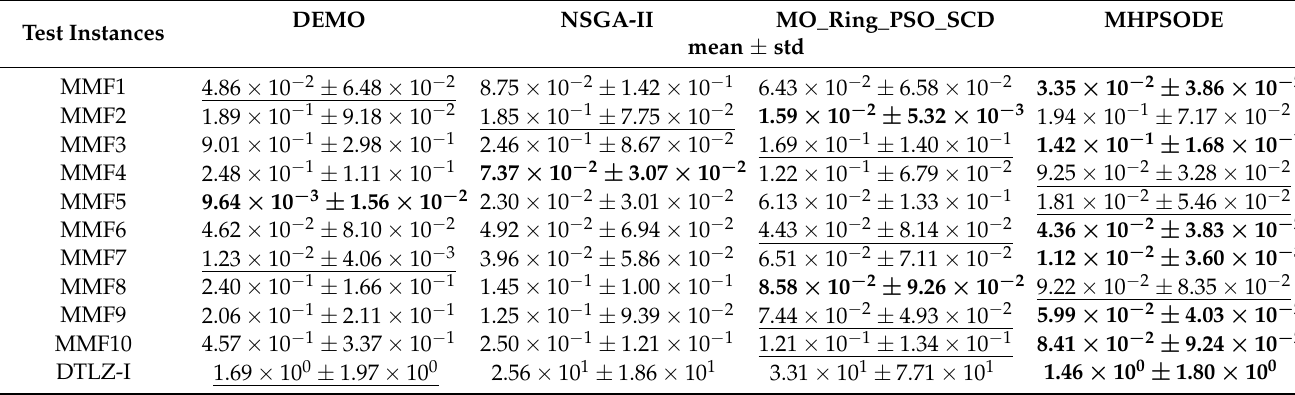
Table 3. The mean and standard deviation values of IDG metrics for different considered optimization algorithms. Test